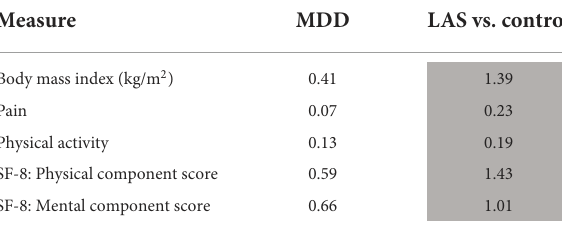
TABLE 2 Minimal detectable differences (MDD) for outcome measures between groups. Measure MDD LAS vs.